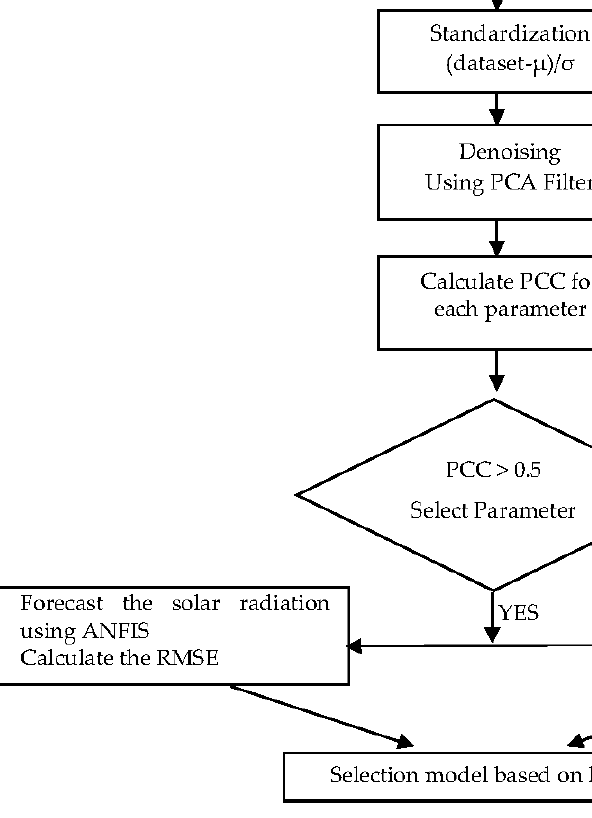
Figure 1. The flow chart of the proposed prediction process.